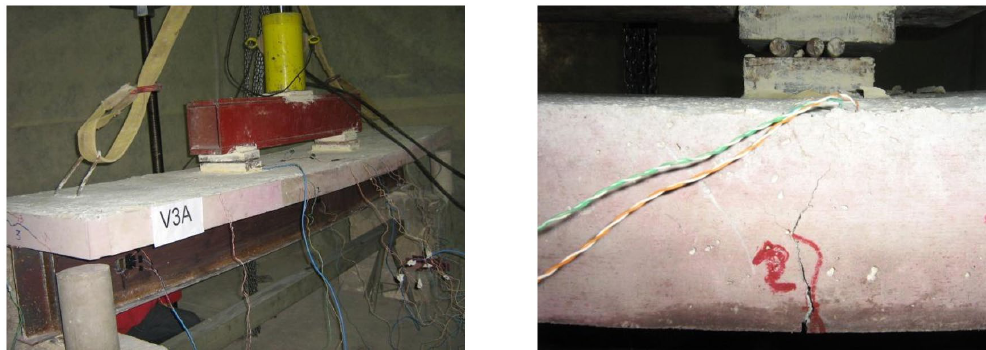
Figure 19. Beam V3A rupture configuration.